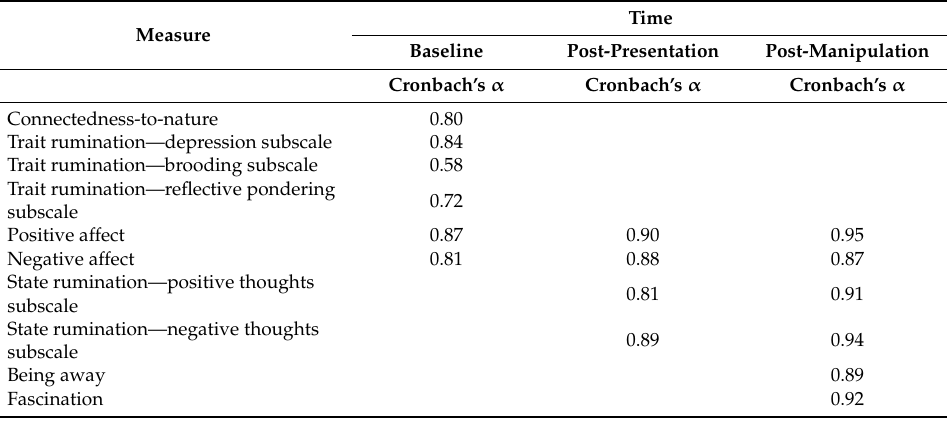
Table 2. Reliability Statistics for all Continuous